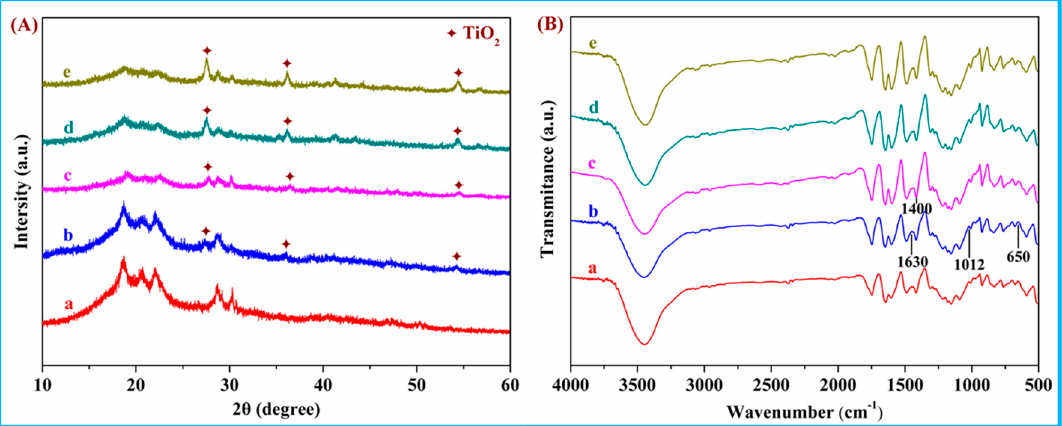
Figure 2. ( A ) X ‐ ray diffractometer (XRD) spectra and ( B ) Fourier transform infrared spectroscopy (FTIR) spectra for the scaffolds with (a) 0 wt %; (b) 1 wt %; (c) 3 wt %; (d) 5 wt %; and (e) 7 wt % nTiO 2 .